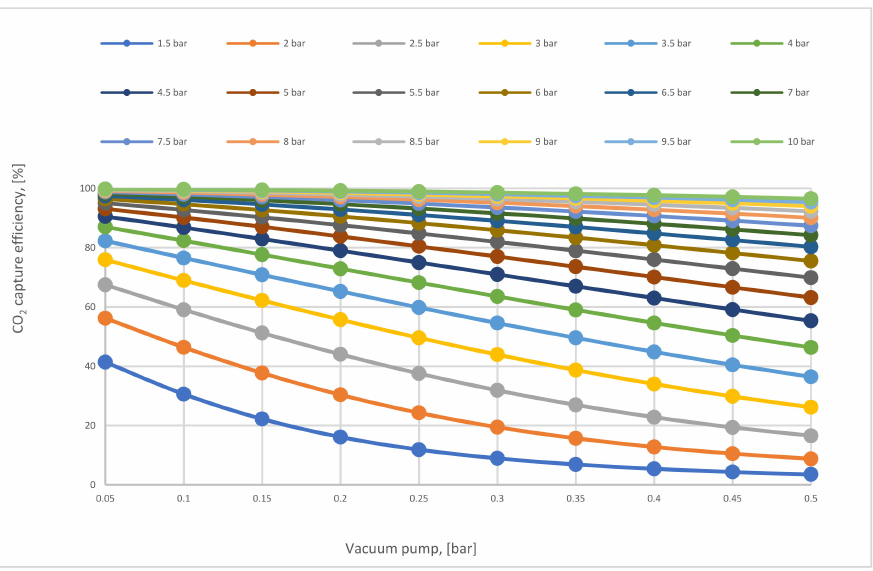
Figure 10. The vacuum pressure difference influence on CO 2 capture efficiency for 1-stage (case A, B) at 200,000 m 2 of 1st membrane